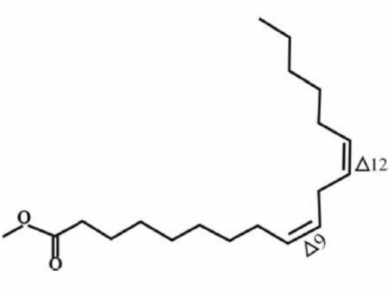
Figure 1. Structure of methyl linoleate.